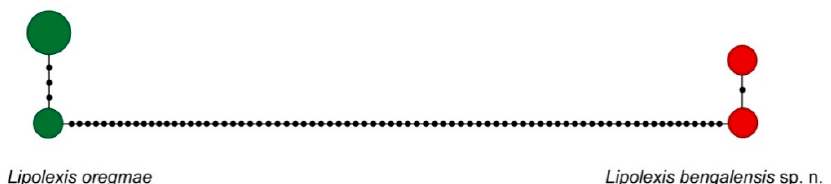
Figure 2. Haplotype network of COI sequences obtained from specimens in the L. oregmae group . The circle size indicates the number of specimens with a particular haplotype; each black dot represents a nucleotide substitution.